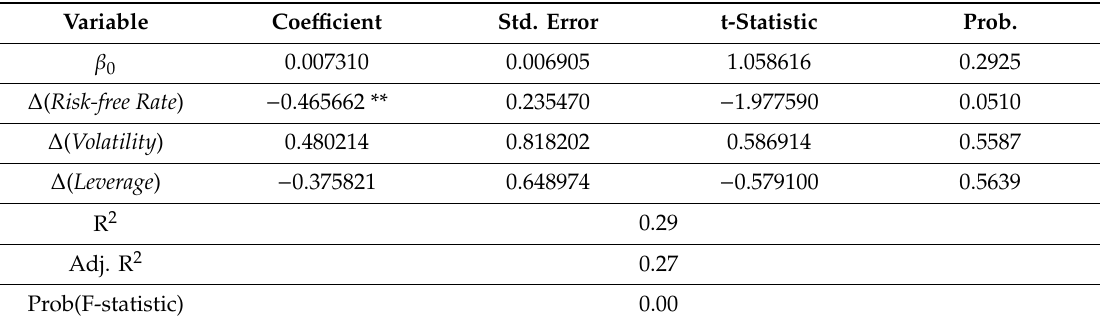
Table A4. OLS estimates: period March 2018–September 2018 (96 Obs.).